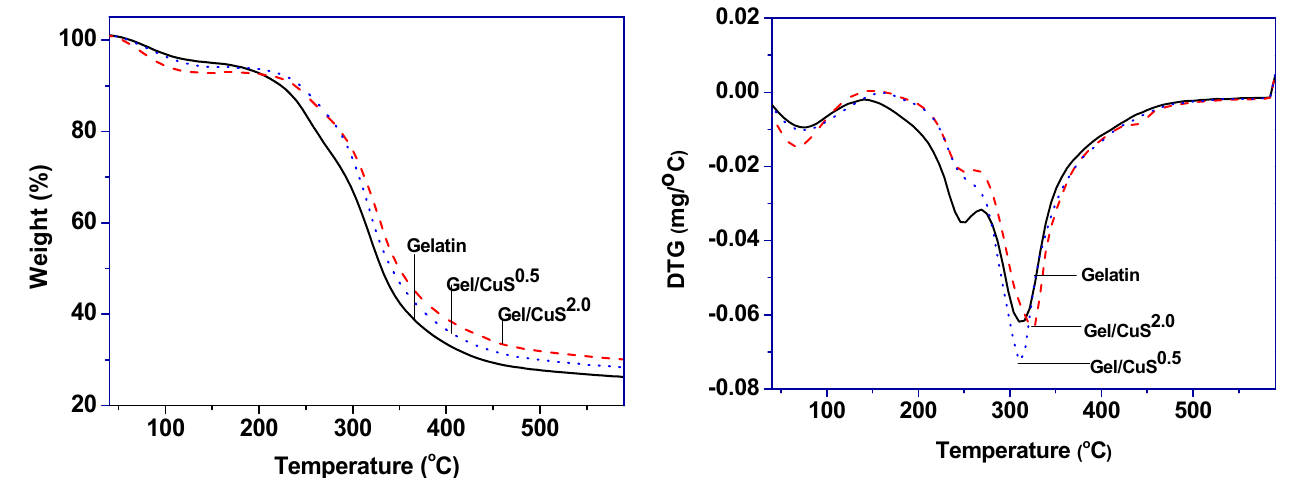
Figure 5. TGA and DTG thermograms of Gel/CuSNP films (in a nitrogen atmosphere and a heating rate of 5 °C/min).